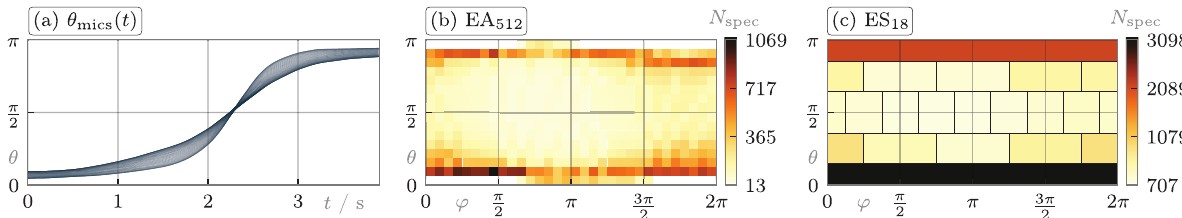
Figure 9. Latitudinal angle timeline of the ring microphones in the drone ’ s coordinate system (a) and histograms of how many short- time spectra are calculated per respective grid segment (b, c).